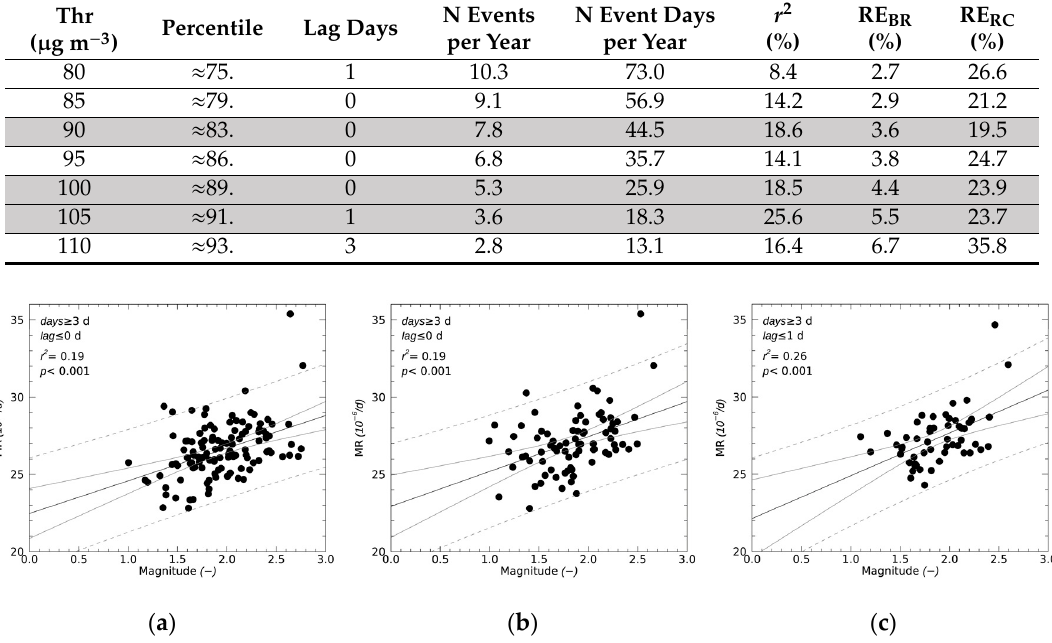
Figure 5. Regressions between mean mortality rates (MRs; y -axis) during OE from 2000 to 2014 in Berlin, and event magnitudes ( x -axis) for selected thresholds, based on observations at site Wedding (urban station #1). ( a ) Maximum daily eight-hourly average ozone concentration (MDA8) > 90 µ g m − 3 (zero lag days); ( b ) MDA8 > 100 µ g m − 3 (zero lag days); ( c ) MDA8 > 105 µ g m − 3 (one lag day).